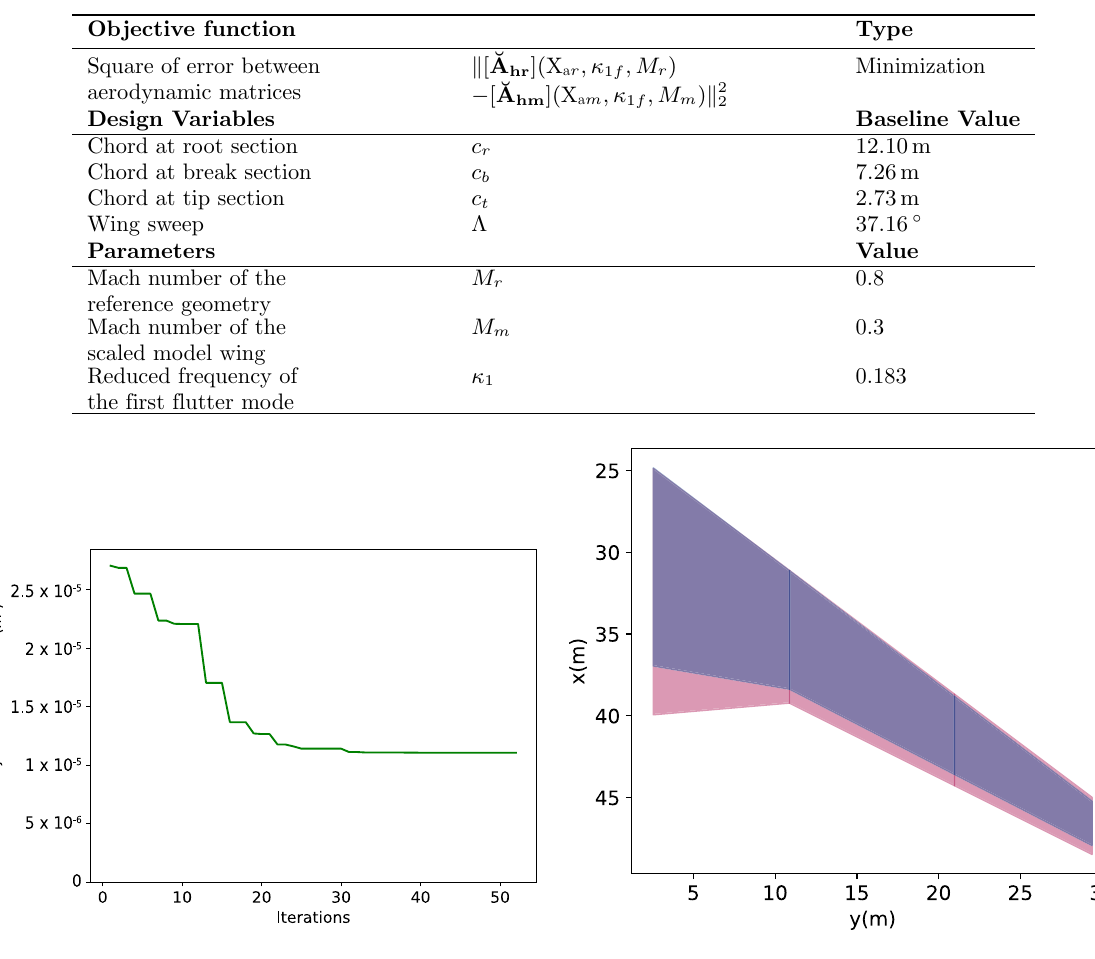
Table 2. Objective function, design variables, and parameters of the flutter optimization problem.